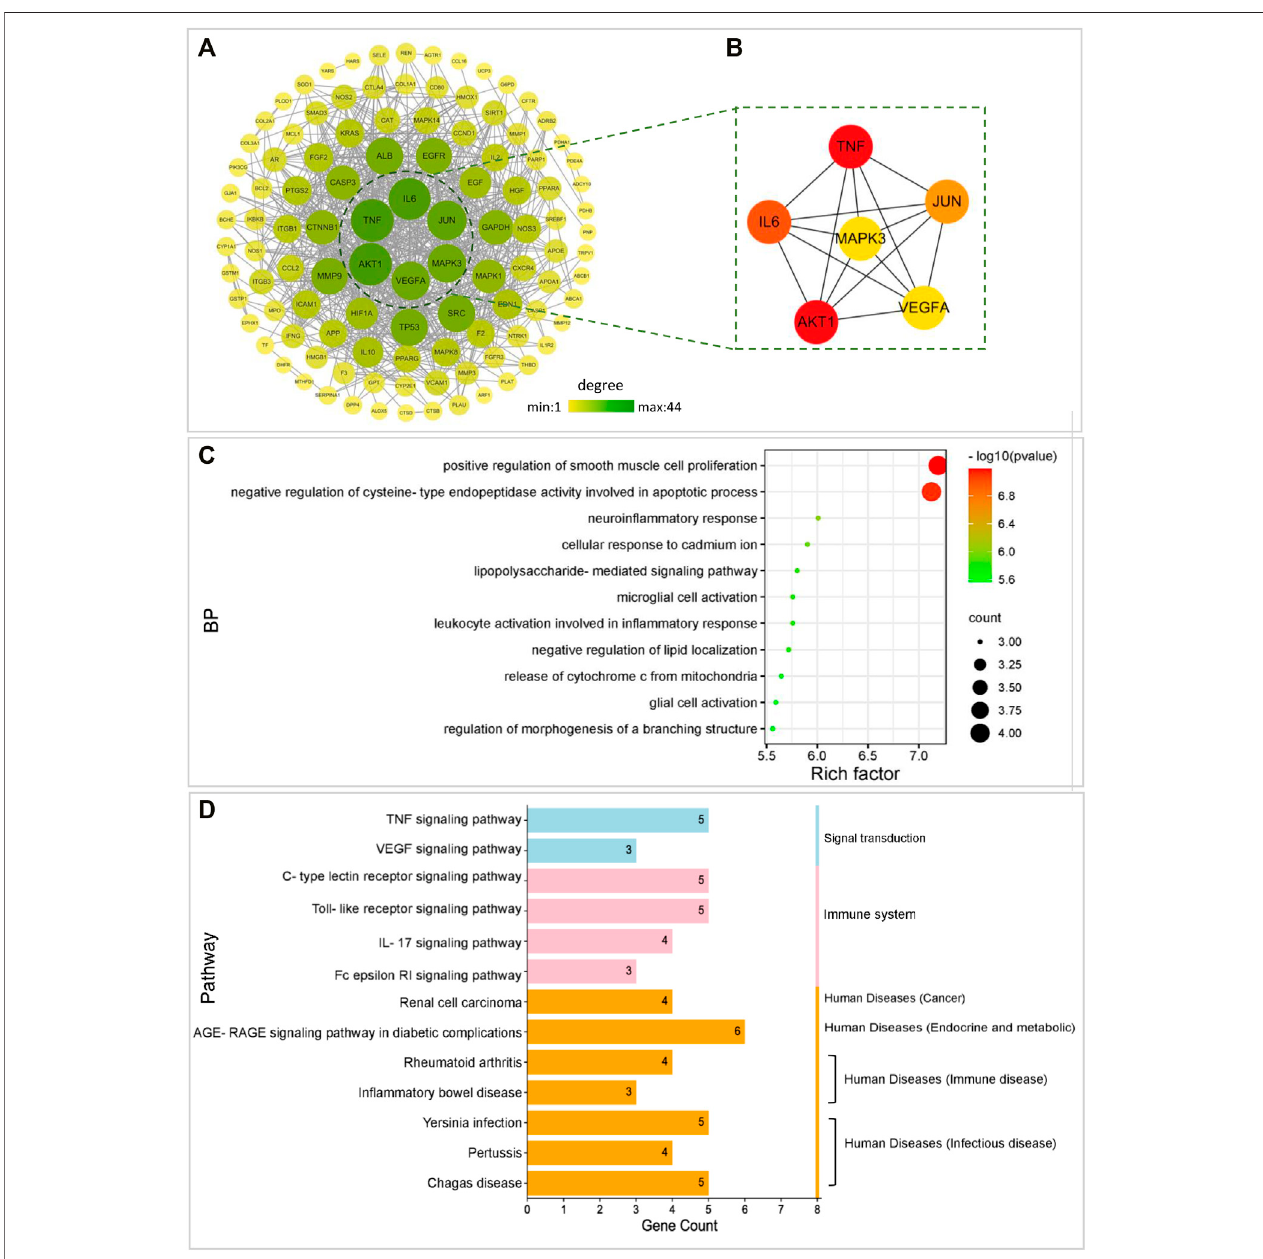
FIGURE 3 | The underlying mechanisms by which FLKM affects pneumonia as determined by a network pharmacology approach. (A) PPI networks of 115 overlapping targets of both FLKM and pneumonia. The color and size of a node represent them degree value of a target in the network. (B) . The top six hub targets of both FLKM and pneumonia were identi fi ed and arranged according to their degree value using Cytoscape software. (C-D) With the ClueGO plugin of Cytoscape software, the six hub targets were subjected to GO analysis of biological process (BP) terms and KEGG pathway analysis.